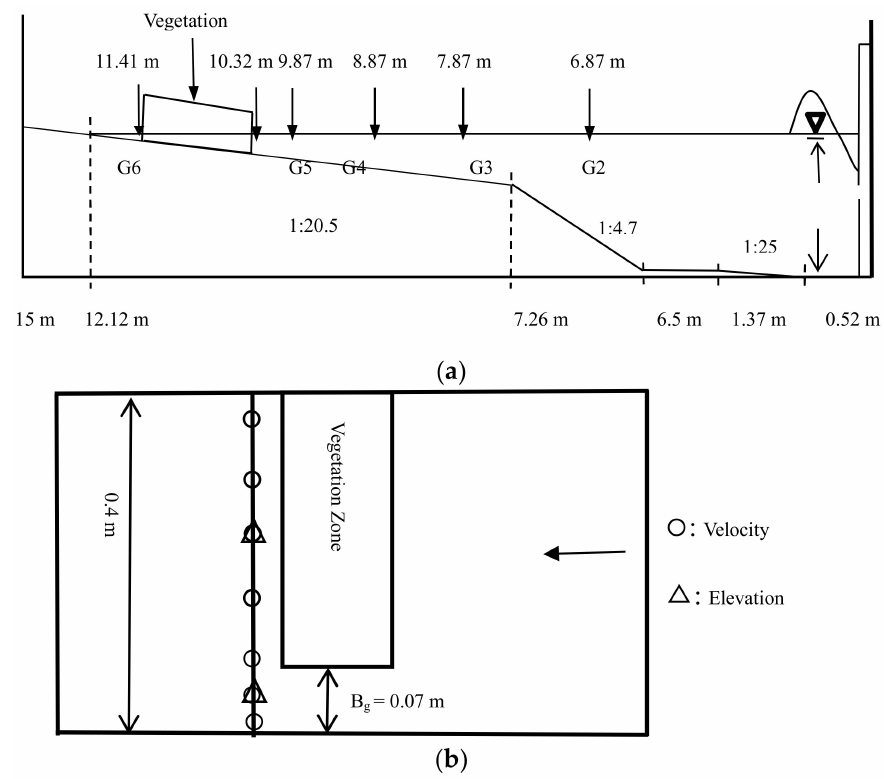
Figure 5. Experimental setup of wave flume. ( a ) Longitudinal section, ( b ) plan view of vegetation zone and measurement